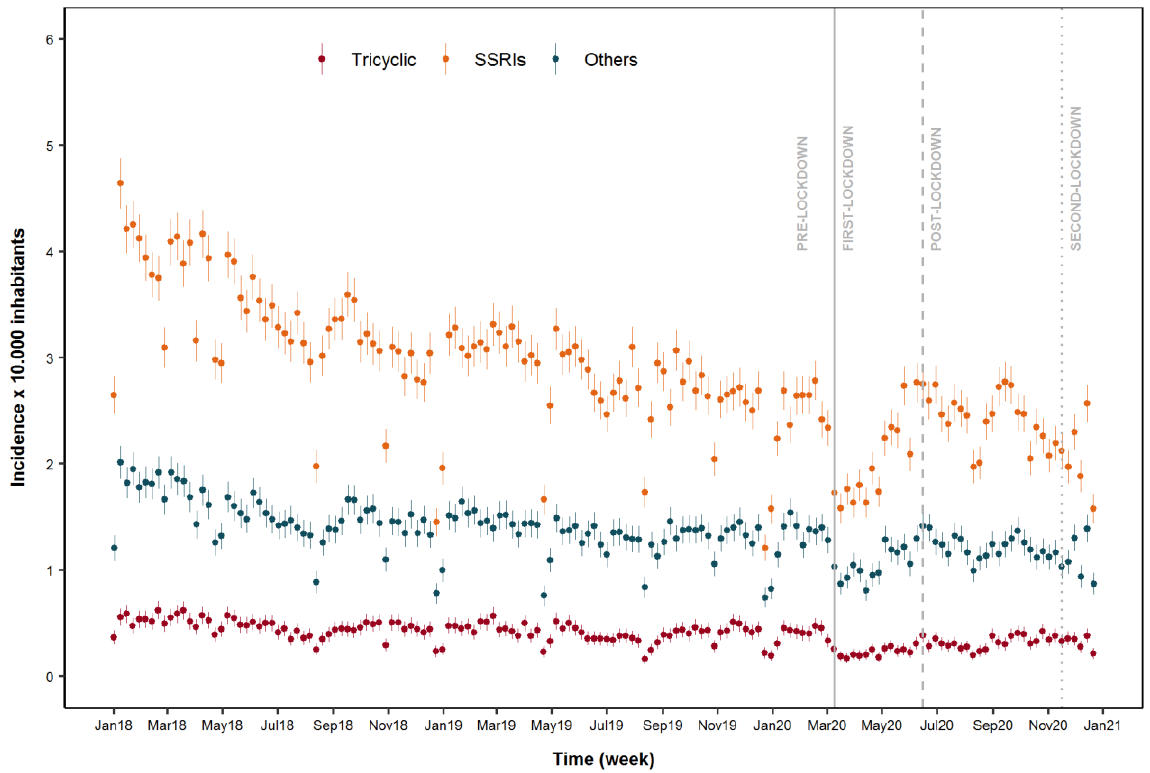
Figure A1. Incidence of different antidepressant drugs (ADs) classes use in the general population in the study period. Legend: Orange dots: estimated incidence of Selective Serotonin Reuptake inhibitors (SSRIs); blue dots: estimated incidence of Others antidepressants and red dots: estimated incidence of tricyclic antidepressants.